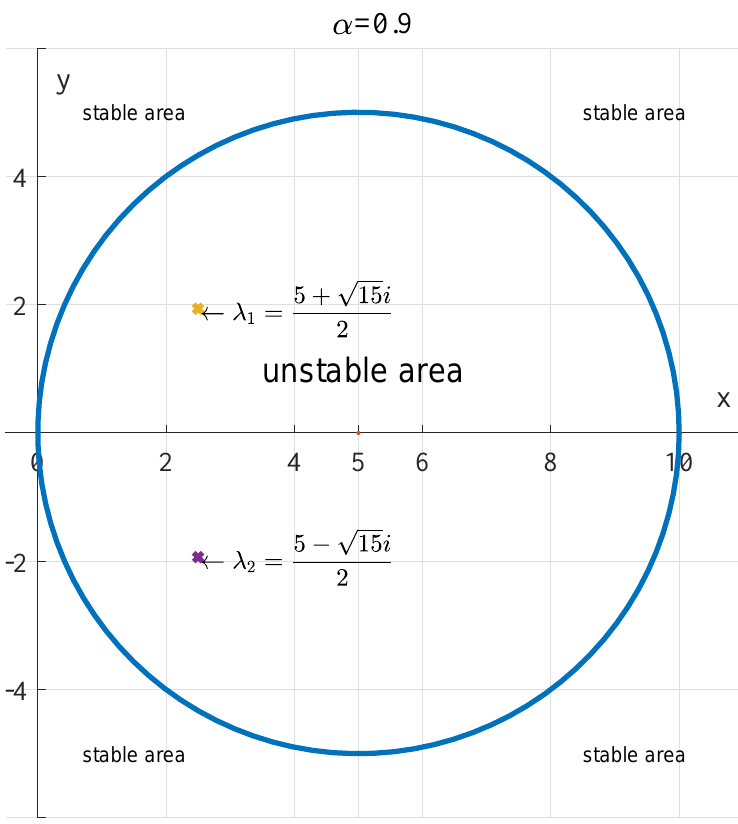
Figure 6. When α = 0.9, system (14) is